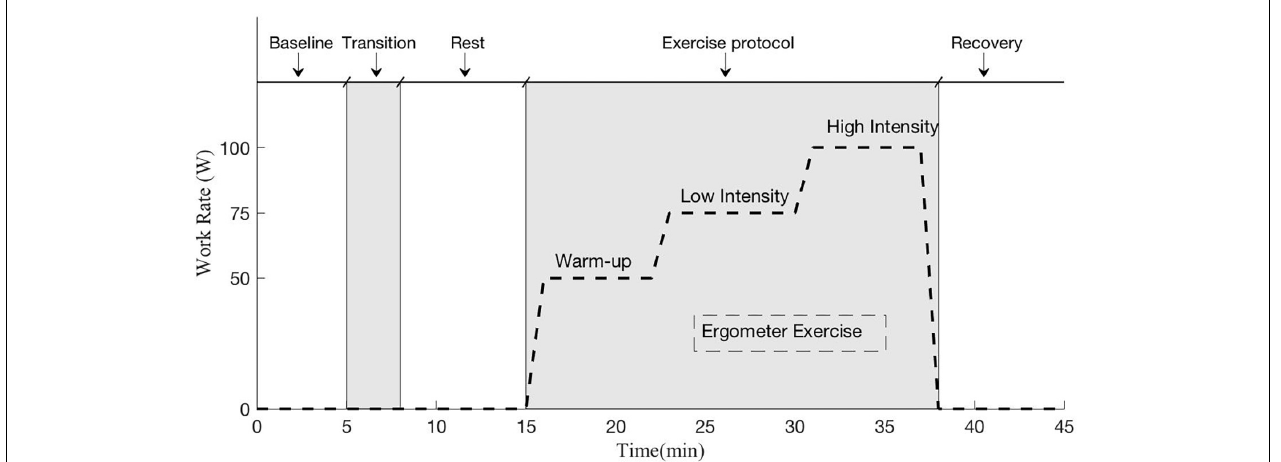
FIGURE 2 | Exercise protocol implemented during each experimental session. The protocol included a baseline session in seated position (5 min), a transition period to position the subject in the desired testing configuration (Microgravity − 6 ◦ HDT, Moon + 9.5 ◦ HUT, Mars + 22.3 ◦ HUT, Earth + 90 ◦ upright), another period at rest to capture the new baseline in the new gravitational configuration (7 min), the ergometer exercise period (23 min including work rate transitions), and a final recovery period (7 min).